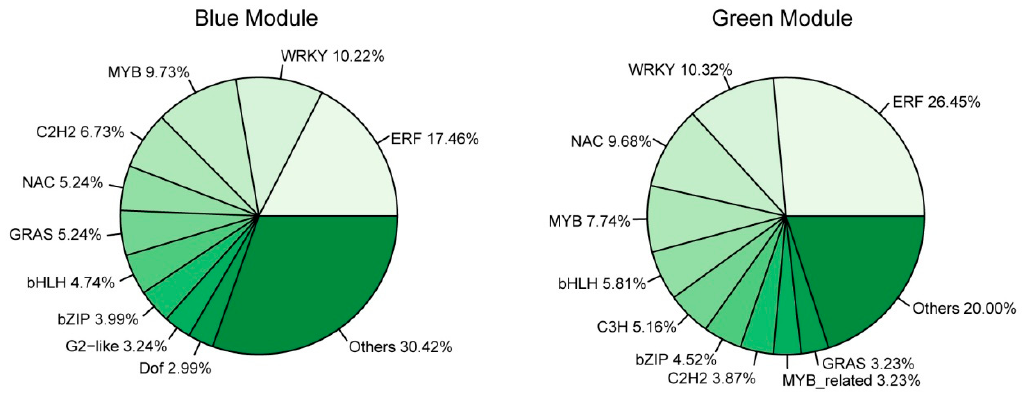
Figure 9. The proportion of genes in the top 10 abundant transcription factor (TF) families in blue and green ( right ) (left) and green (right) modules.